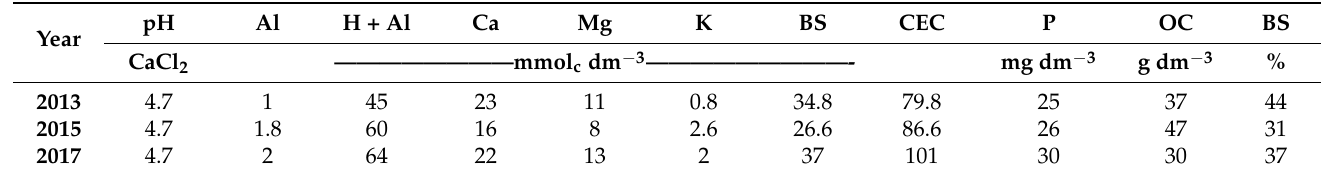
Table 2. The soil chemical characterization (0–0.20 m) of the experimental area performed in 2013, 2015, and